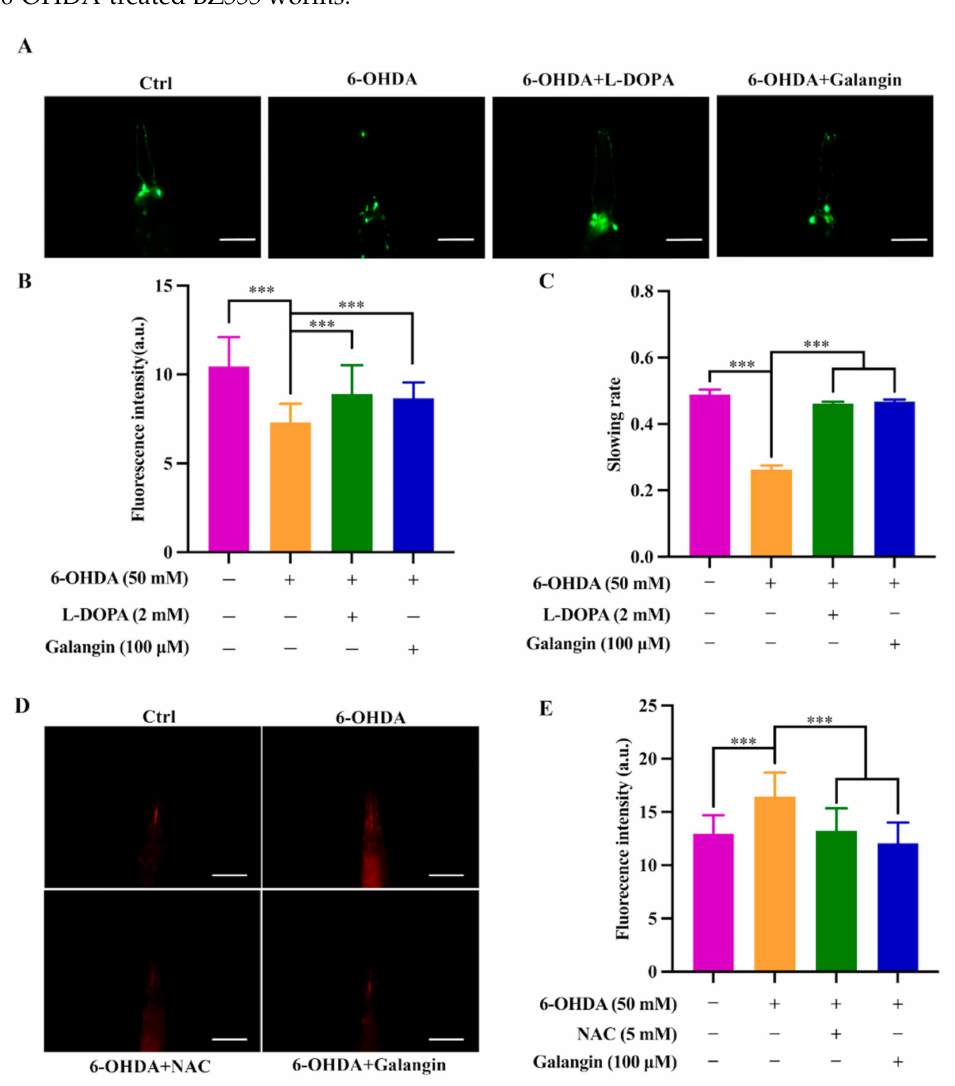
Figure 7. Galangin exerts a neuroprotective effect in 6-OHDA-treated BZ555 worms. ( A ) Representa- tive images of BZ555 worms treated with galangin (100 µ M) or L-Dopa (2 mM) in the presence or absence of 6-OHDA (50 mM) for 72 h. The GFP represents the viability of DA neurons. Magnification: Scale bars: 20 µ m. ( B ) The bar chart indicates the quantification of GFP intensity in BZ555 worms. Bars, S.D., *** p ≤ 0.001. ( C ) The bar chart indicates the relative slowing rate (%) of BZ555 worms treated with galangin (100 µ M) or L-Dopa (2 mM) in the presence or absence of 6-OHDA (50 mM) for 72 h. Bars, S.D., *** p ≤ 0.001. ( D ) BZ555 worms were treated with galangin (100 µ M) or NAC (5 mM) for 72 h in the presence or absence of 6-OHDA (50 mM), which was followed by incubation with DHE solution (100 µ M) for 1 h. Representative images of worms were captured by a fluorescence microscope. Magnification: Scale bars: 20 µ m. ( E ) The bar chart indicates the relative RFP. Bars, S.D., *** p ≤